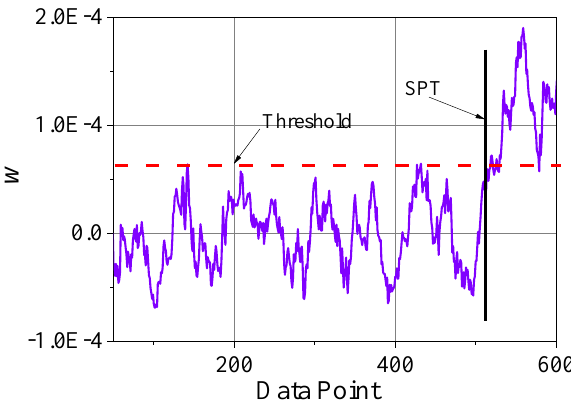
Figure 3. Schematic diagram of SPT.